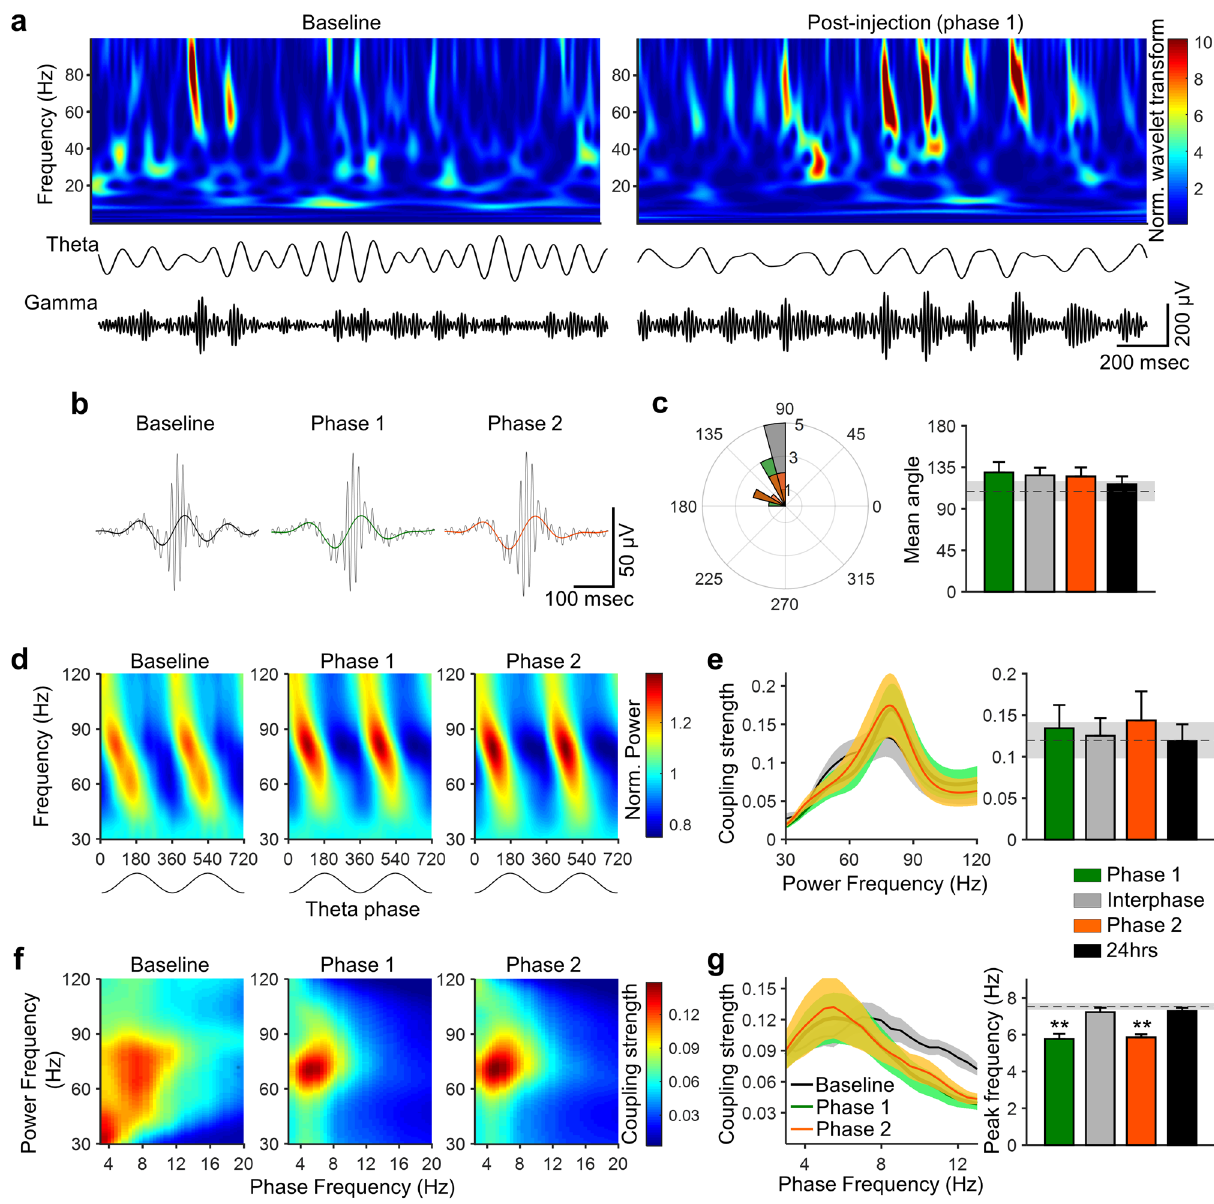
Figure 5. Cross-frequency coupling between theta phase and gamma power reveals peak shift of theta phase frequency during nociceptive phases. ( a ) Top: an example of normalized wavelet transform of local field potentials in the somatosensory cortex before (left) and after (right) formalin injection. Bottom: theta (4–12 Hz) and gamma (60–90 Hz) oscillations. ( b ) Averaged raw (black) and theta-range filtered (black: baseline, green: phase 1, orange: phase 2) traces obtained by aligning the signals at the peak of gamma oscillations. ( c ) Left: distribution of the mean direction of gamma power for the theta cycle phase. Right: mean direction of gamma power for the theta cycle phase in each phase. Mean direction did not differ after formalin injection. ( d ) Color-coded gamma power as a function of theta phase. ( e ) Left: strength of theta modulation of gamma as a function of power frequency. Right: averaged theta-gamma coupling. Theta-gamma coupling strength did not differ after formalin injection. ( f ) Phase-power comodulogram between power of high-frequency oscillation and phase of low-frequency oscillation at baseline and during nociceptive phases. ( g ) Left: coupling strength of theta modulation of gamma power as a function of phase frequency. Right: peak phase frequency of coupling strength, demonstrating peak frequency is significantly lower during phases 1 and 2, but not during the interphase or at 24-h post-injection. The dashed line and shaded area indicate the mean and SEM at baseline, respectively. Data are presented as mean ± SEM; *P < 0.05 vs. baseline values; repeated measures ANOVA with a post hoc Dunnett’s multiple comparison